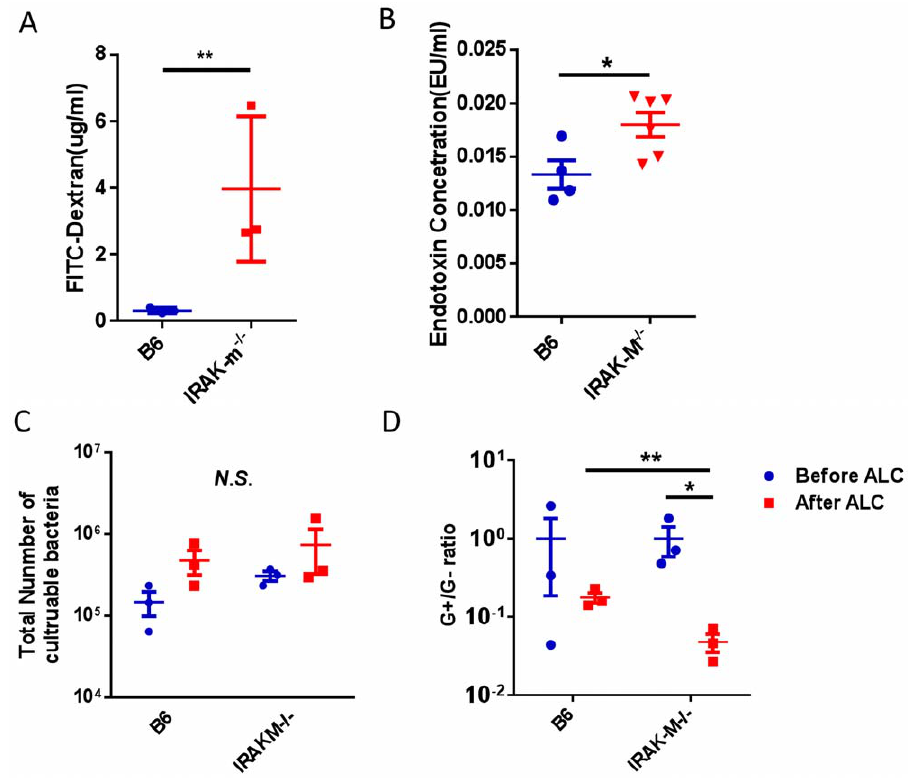
Figure 6. Altered gut permeability and composition of gut bacteria in the intestine after alcohol treatment. (A) FITC-dextran concentration in blood after gut permeability test in wild type B6 mice (blue) and IRAK-M 2 / 2 mice (red). (B) LPS content in the blood of B6 mice (open bar) and IRAK-M 2 / 2 mice (solid bar). (C) Number of culturable bacteria in the intestine before (blue) and after (red) binge alcohol treatment (ALC) in wild type B6 and IRAK-M 2 / 2 mice. (D) G + /G 2 gut bacteria ratio from mouse feces tested by Q-PCR before (blue) and after (red) binge alcohol treatment in wild type B6 and IRAK-M 2 / 2 mice. Experiments were performed 3 times for A and twice for B, C and D. The data presented in A, C and D were from one of the experiments, and those shown in B were from pooled 2 experiments. n=2–3 in each group of each experiment. Error bars represent the SD of samples within a group. * P , 0.05, ** P , 0.01 (Student’s t-test).